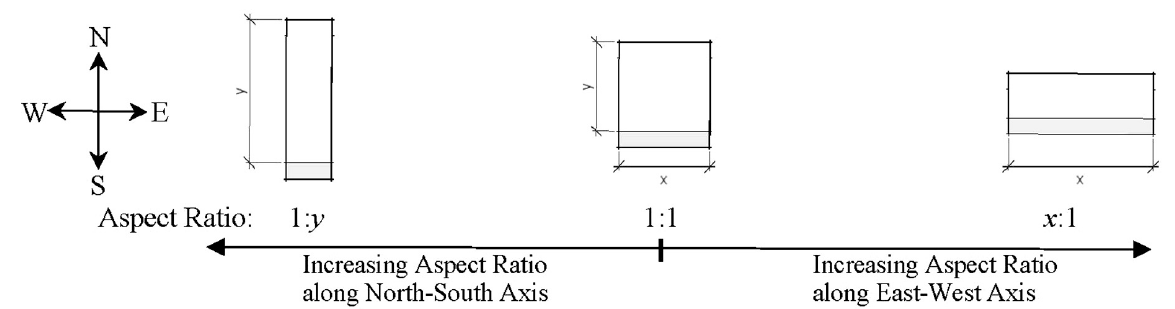
Figure 2. The increase of building dimensions (x,y) will change the aspect ratio along a particular axis.